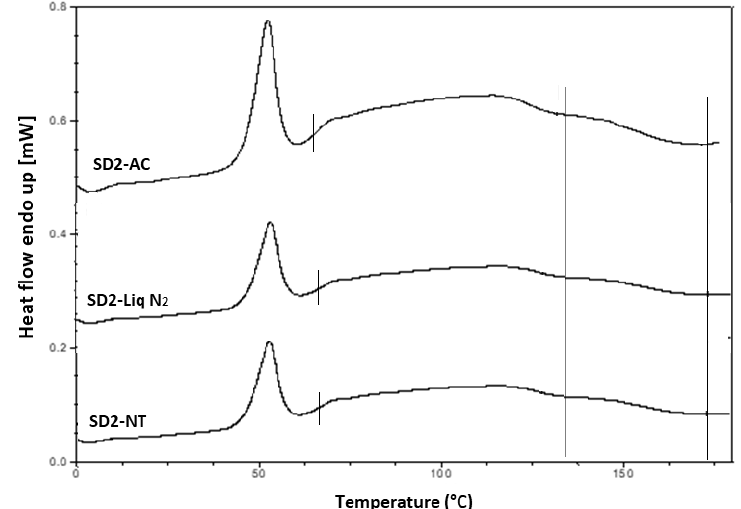
Figure 9. Hyper DSC thermograms of selected SD formulations used to investigate the e ff ect of cooling. P407 was still present in its crystalline form in all formulations (AC = Air cooled, NT = Normal room temperature and Liq N 2 = Liquid Nitrogen). Hyper DSC indicates that INM was converted to its amorphous form. The area of interest for T g is marked by straight lines.